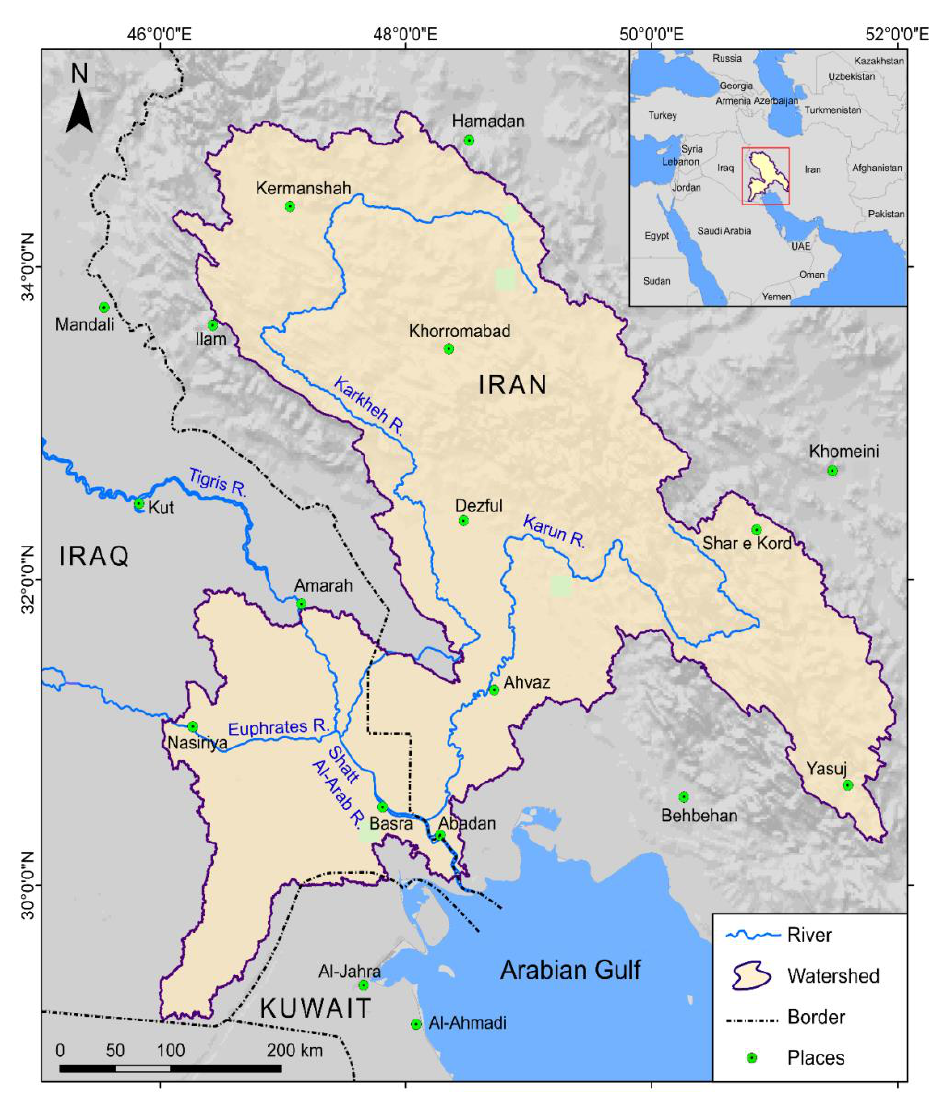
Figure 1. Site map of the trans-boundary Shatt Al-Arab basin (Iraq-Iran) with the Shatt Al-Arab River and its major